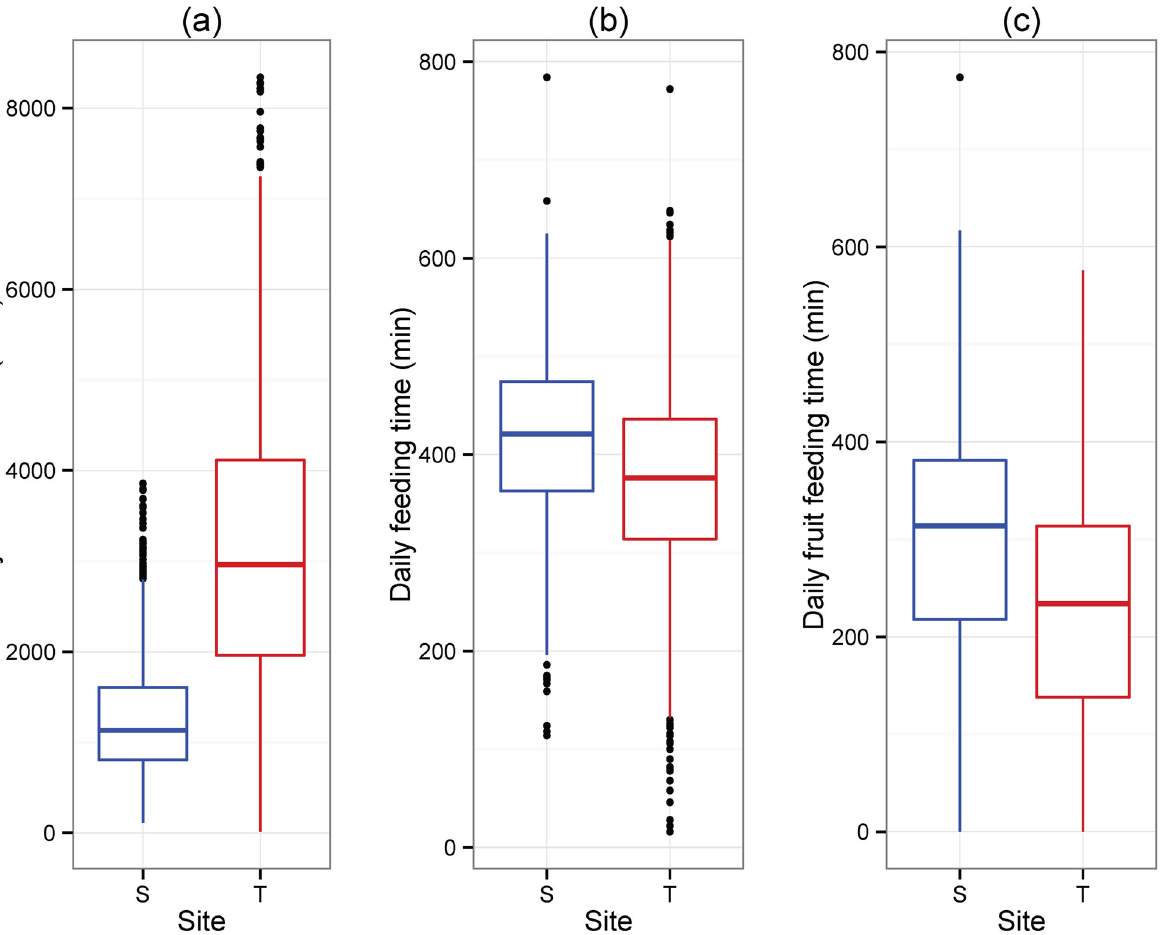
Fig 3. Daily caloric intake (a), total feeding time (b), and fruit feeding time compared (c). Site differences in (a) Daily caloric intake (t-statistic = 12.26, p < 0.0001), (b) Total feeding time (t-statistic = -6.35, p < 0.0001), and (c) Fruit feeding time (t-statistic = -7.19, p < 0.0001) between the two sites. T = Tuanan, S = Sabangau. Generalized additive mixed models (GAMM) were used. A positive t-statistic indicates Tuanan is higher. See Table 3 for models and full statistical